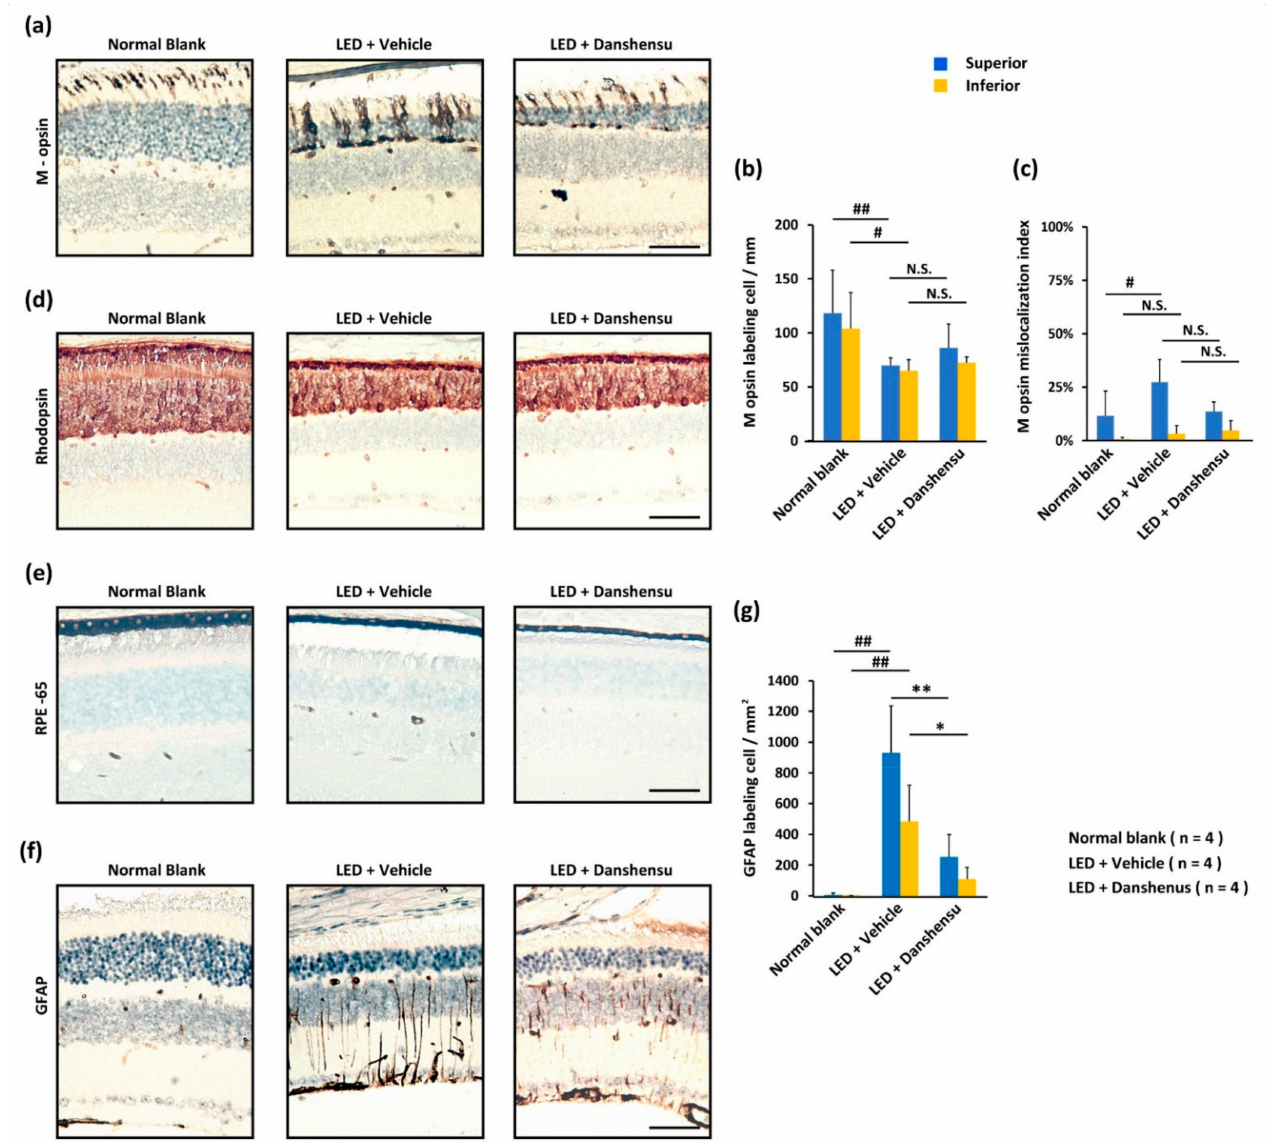
Figure 4. Effect of danshensu on cellular protection after light-evoked retinal damage. ( a ) IHC staining showing the alterations of the photoreceptor-specific function of M opsin protein; ( d ) and Rhodopsin in the retinas; ( b ) Representation of M opsin-labeled cell density; ( c ) and the percentage of M opsin mislocalization; ( e ) Alterations in the pigment cell layer of outer blood-retinal-barrier (outer BRB) when labeled with RPE65 protein; ( f ) The pathologic Müller cells of inner blood-retinal-barrier (inner BRB) when labeled with GFAP protein; ( g ) Representation of the density of GFAP-labeled cells. Data are mean ± SD. Mann–Whitney U test, N.S., non-significant. ## p < 0.01, # p < 0.05, compared with the blank group. ** p < 0.01, and * p < 0.05, compared with the vehicle group. Scale bar: 35 µ